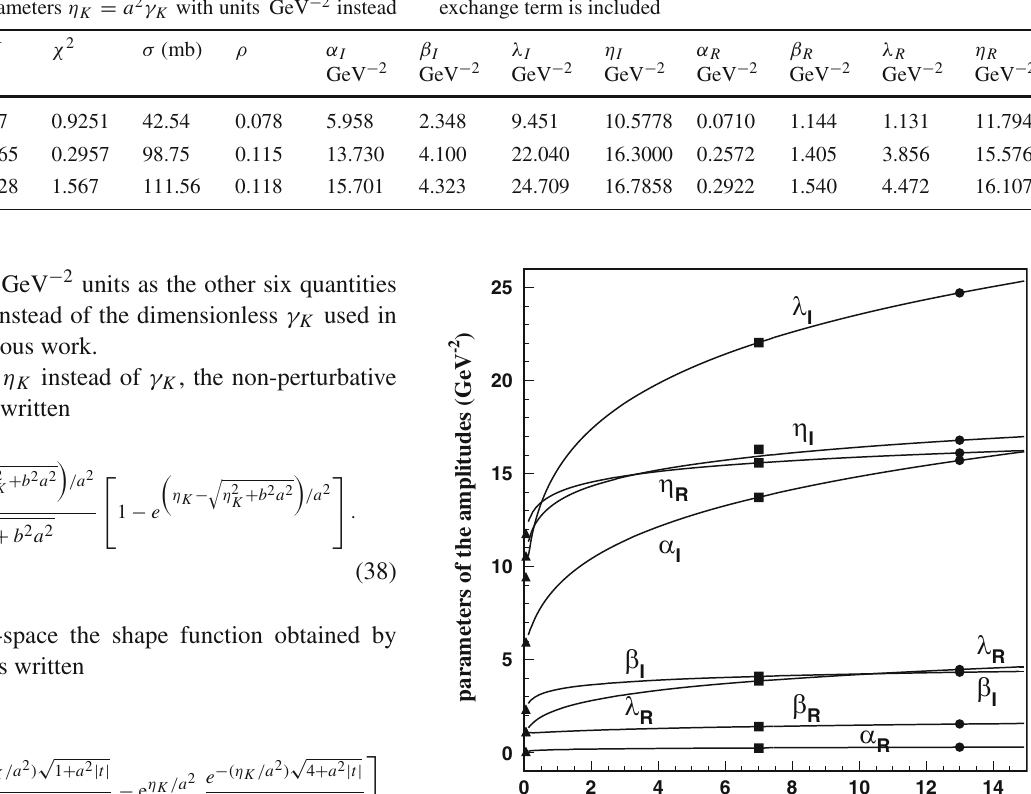
of the dimensionless γ K . Notice values of a 2 for different energies. For 0.0528 TeV the data reaches | t | = 10GeV 2 and the three-gluon